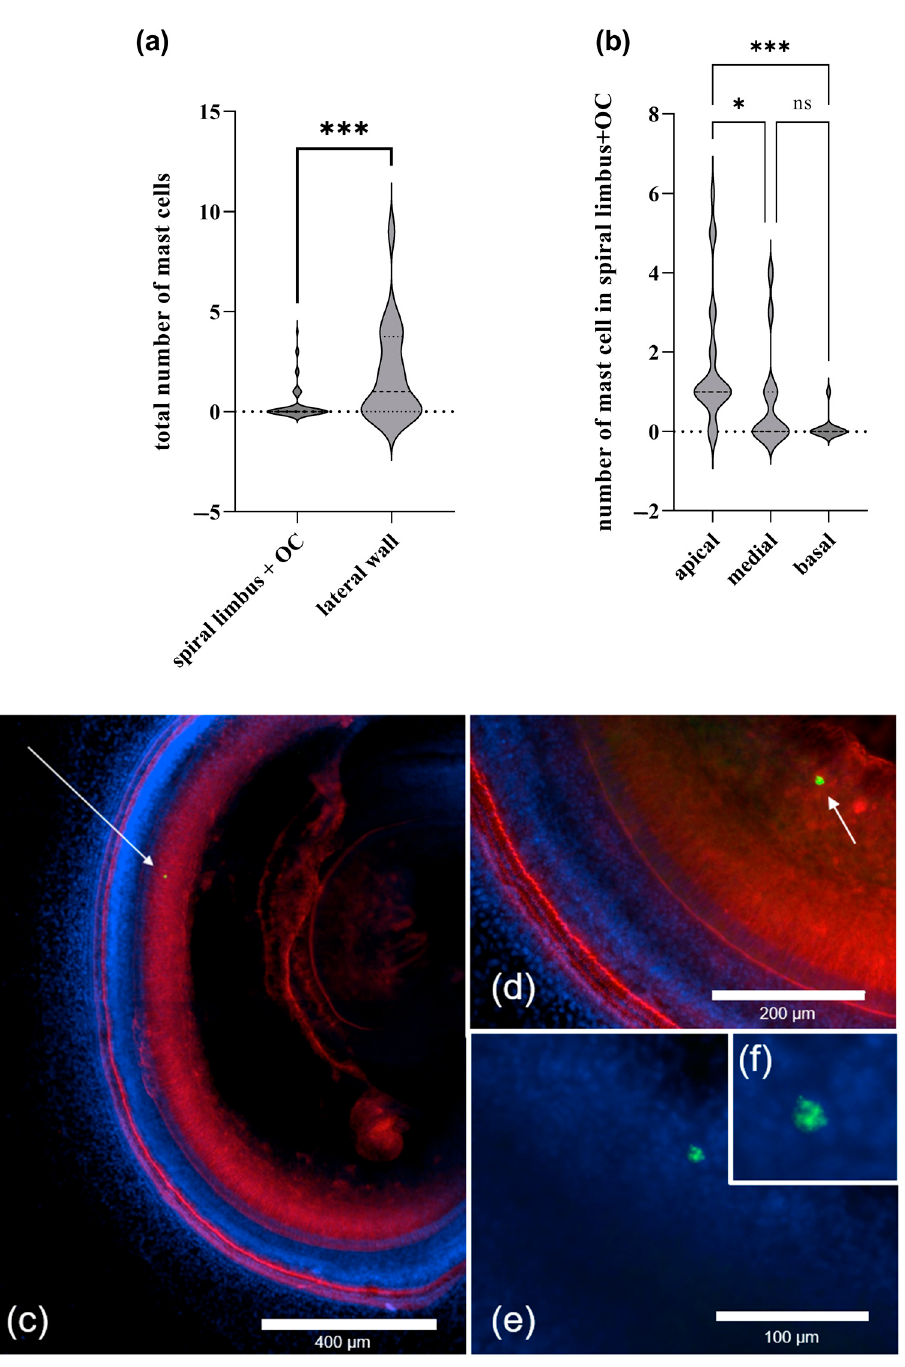
Figure 1. Distribution of MCs in the membranous cochlea. The MCs were scored in each cochlear preparation, and the results are presented as a total number of MCs (non-degranulated and degranu- lated) per area (( a ) n = 7; ( b ) n = 9). ( a ) Violin plot demonstrating MCs distribution in the explant areas containing either spiral limbus with OC or the lateral wall; ( b ) Violin plot demonstrating MCs distribution in the apical, medial, and basal parts of the cochlea; the marker shows the mean. ( c – f ) Representative micrographs showing the cochlear MCs in the medial part of the cochlea. The explants were stained with phalloidin-iFluor 594, avidin–Alexa Fluor ™ 488, and DAPI. The arrows point to MCs. ( f ) contains a digital enlargement of the MC image form ( e ). The data were derived from two independent experiments, and the differences were calculated for means. “ns” indicates not significant ( p > 0.05); * p < 0.05; *** p < 0.001. (( a ) Kruskal–Wallis test; ( b ) Mann–Whitney